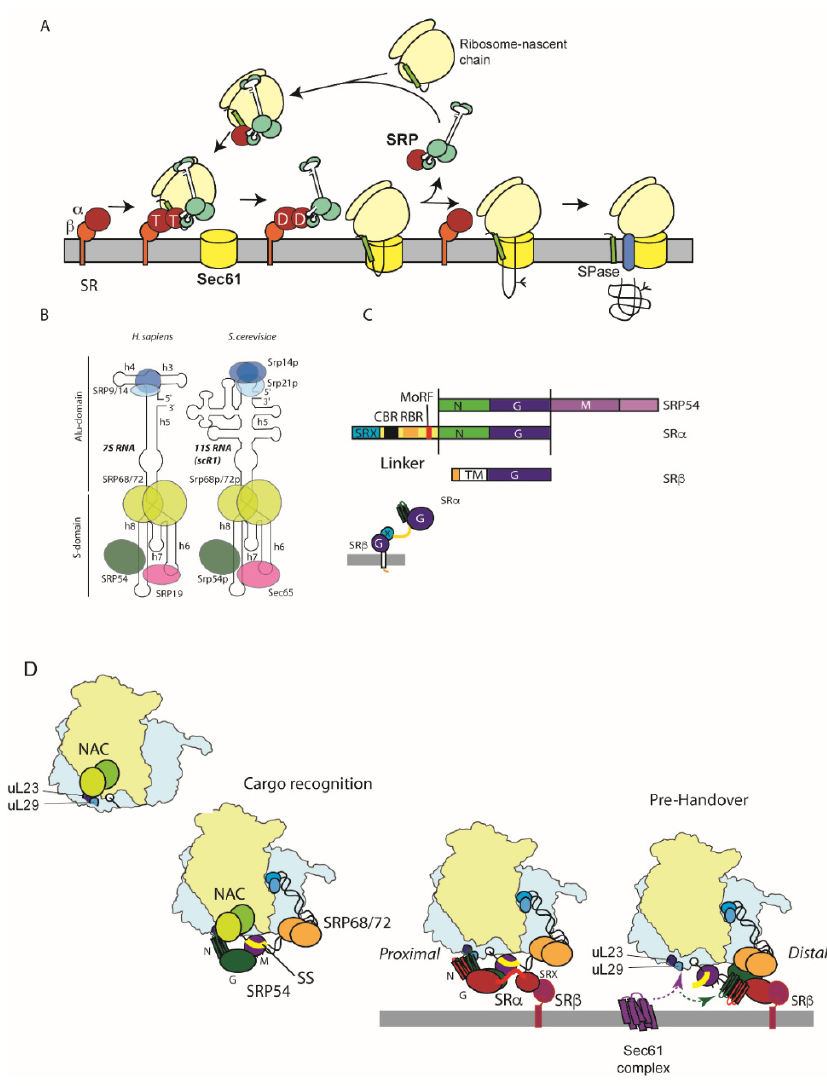
Figure 2. SRP-dependent targeting pathway: ( A ). Overview of the SRP targeting pathway: SRP can bind to ribosomes and scan for the presence of a signal sequence in the nascent chain as the N-terminus emerges from the ribosome exit tunnel. Engagement with the nascent chain with the SRP54 subunit (red) leads to a transient retardation in translation elongation and targeting to the ER membrane via an interaction with SRP receptor (SR). Complex formation between SRP and SR is driven by GTP (T) binding to SRP54 and SR α . The Sec61 translocase triggers release of signal